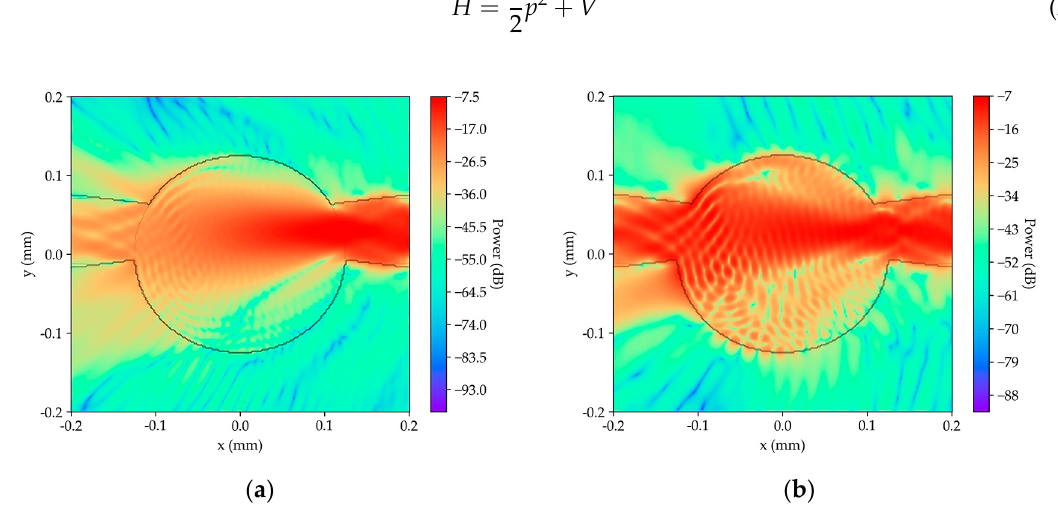
Figure 4. Simulation of the geometry: ( a ) frame 103 and ( b ) frame 143.